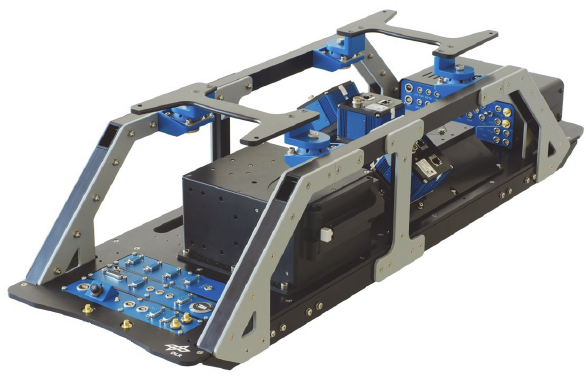
Figure 1. MACS-Himalaya aerial